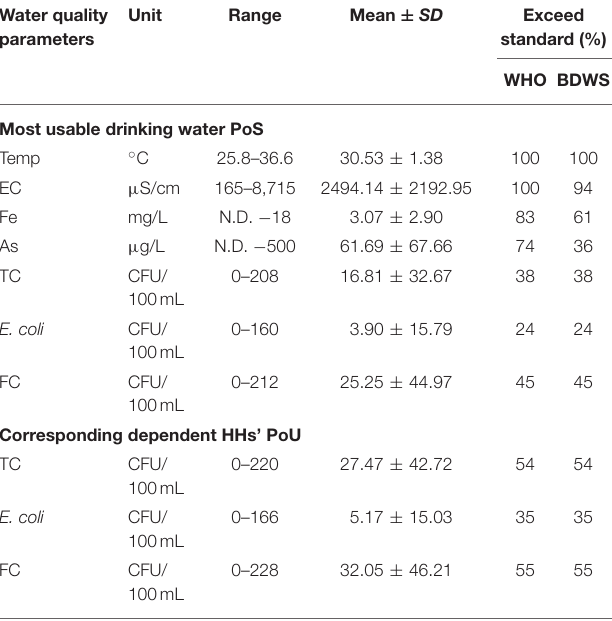
TABLE 2 | Basic statistics of water quality parameters in PoS and PoU.